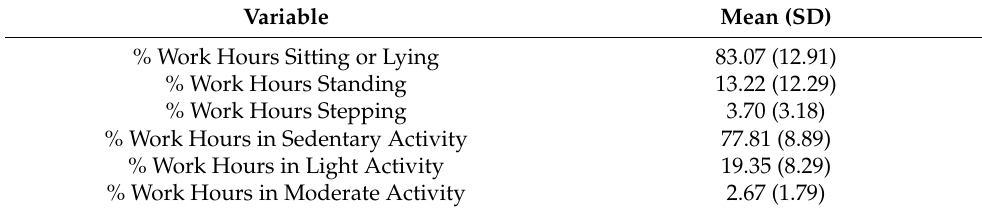
Table 5. Regression Coefficients for Work Activity Variables and Physiological Table 4. Descriptive Statistics for Physical Activity and Postural Classifications.